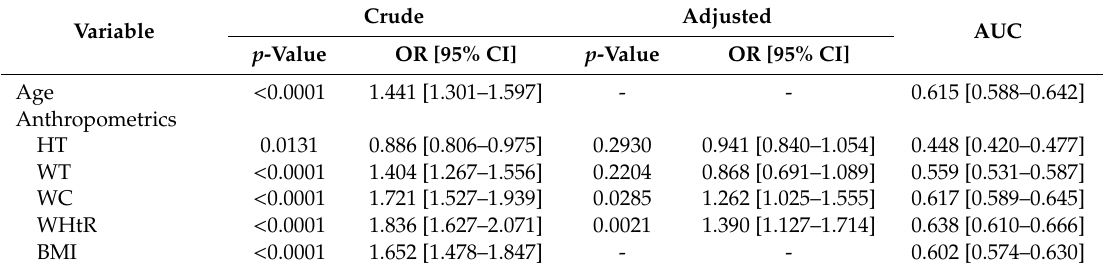
Table 3. Associations of hypertension with anthropometric and body composition indices in